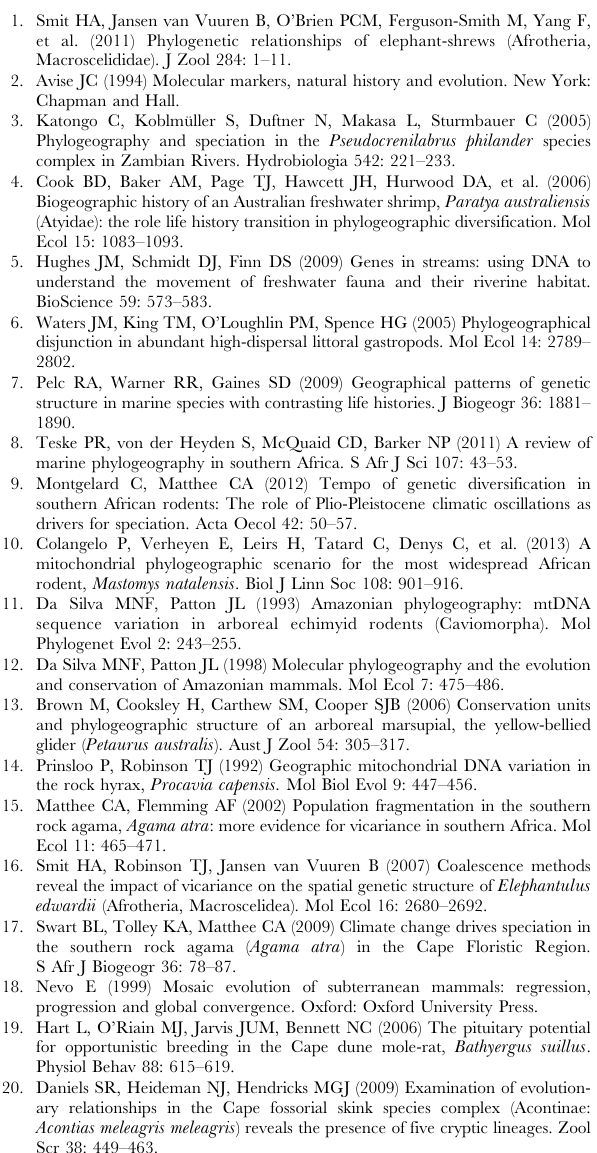
Table S3 Microsatellite data used in this study.